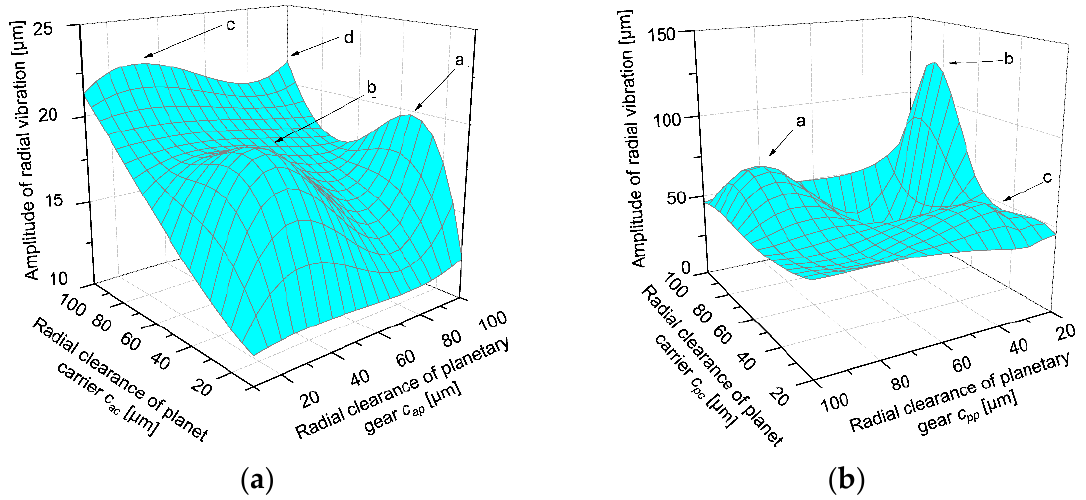
Figure 9. The amplitude of radial vibration for antenna reflector with different radial clearance combinations ( a ) caused by radial clearance coupling in the azimuth joint and ( b ) caused by radial clearance coupling in the pitch joint. Table 4. The peak value of radial vibration for antenna reflector in Figure 9a. Peak